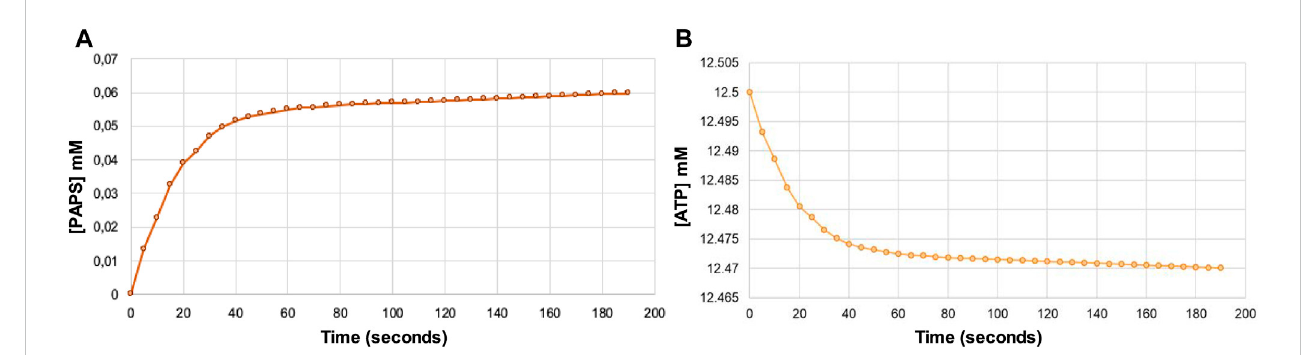
FIGURE 5 IndirectestimateoftheformationofPAPS (A) andtheconcomitantATPconsumption (B) overreaction timefromthedecreaseinabsorbance at340 nm due to NADH oxidation using the Lambert-Beer law. Note that the formation of one PAPS molecule requires the consumption of two ATP molecules.